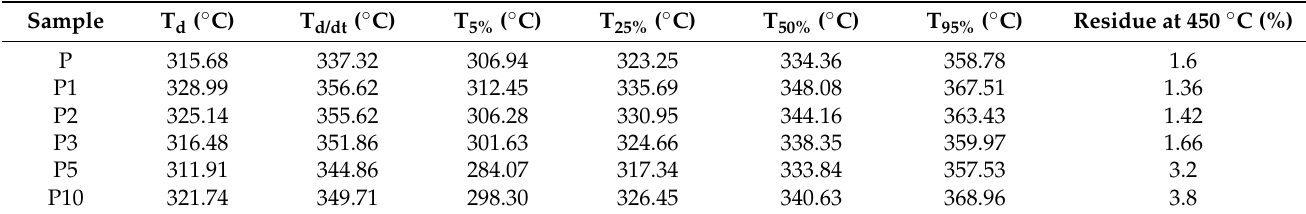
Table 3. Temperatures of decomposition (T d ) and temperatures (T 5% , T 25% , T 50% , and T 95% ) corresponding to mass losses of 5%, 10%, and 95%, derived from TG and TG/DT curves.